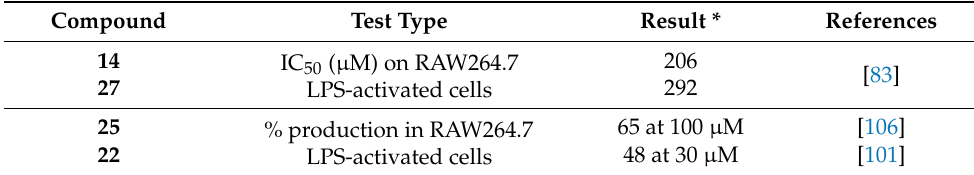
Table 8. Effect of TNF- α release by PMFs and